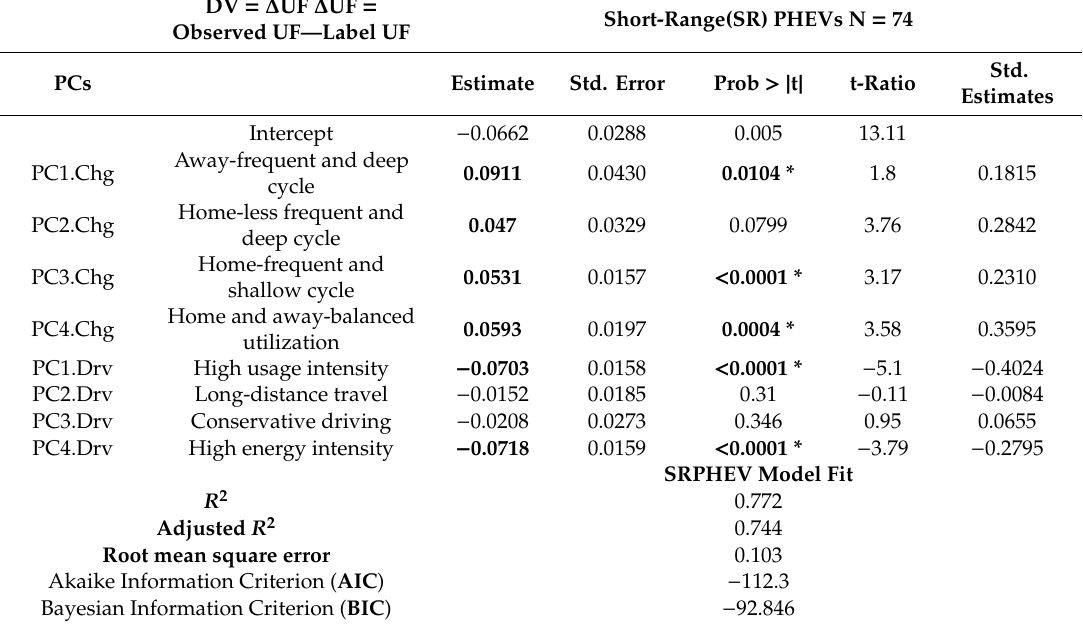
Table 9. OLS Regression Model Results: Short-range PHEVs